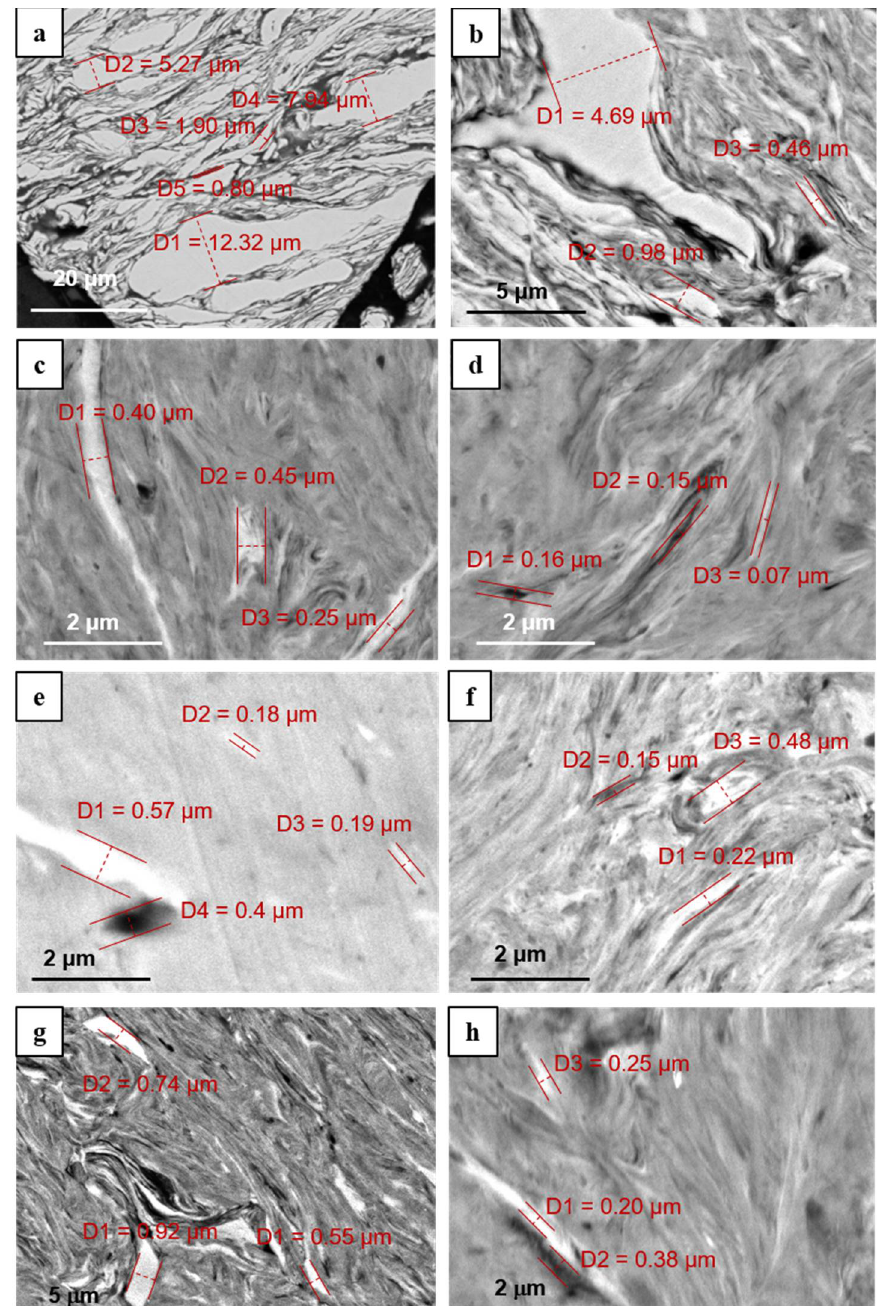
Figure 2. BSE-images of Ni 36 Al 27 Co 37 powders after MA in the planetary mill ( a – f ) and in the attritor ( g , h ) at the modes ( a ) 150/−300 5 h; ( b ) 150/−300 15 h; ( c ) 150/−300 25 h; ( d ) 200/−400 15 h; ( e ) 200/−600 15 h; ( f ) 200/−400 20 h; ( g ) 250 4.5 h; and ( h ) 250 10 h. ( g , h ) at the modes ( a ) 150/ − 300 5 h; ( b ) 150/ − 300 15 h; ( c ) 150/ − 300 25 h; ( d ) 200/ − 400 15 h; ( e ) 200/ − 600 15 h; ( f ) 200/ − 400 20 h; ( g ) 250 4.5 h; and ( h ) 250 10